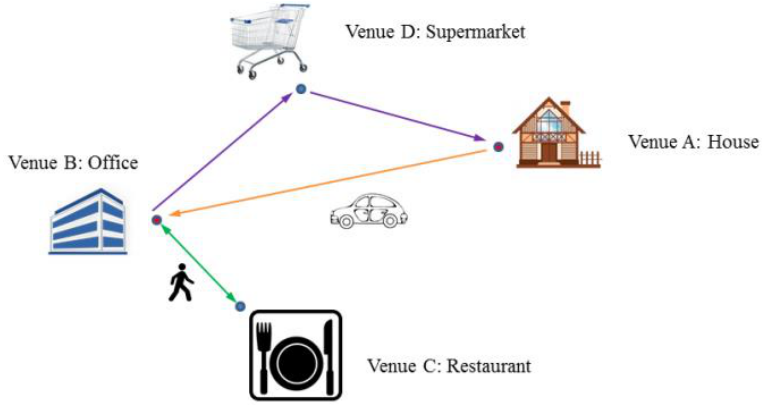
Figure 1. Trips taken by Foursquare users between venues